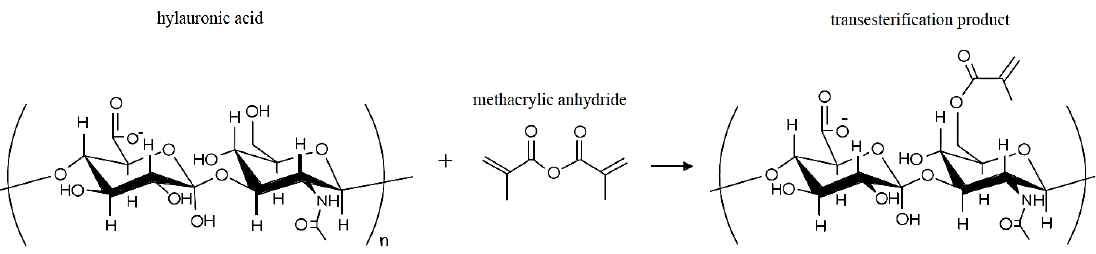
Figure 1. Scheme depicting the methacrylation of hyaluronic acid.